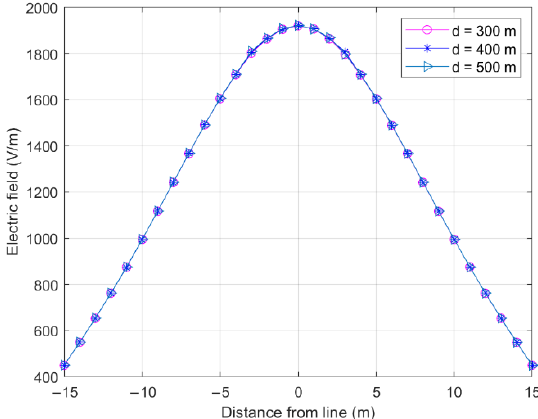
Figure 6. Span configurations of different lengths.